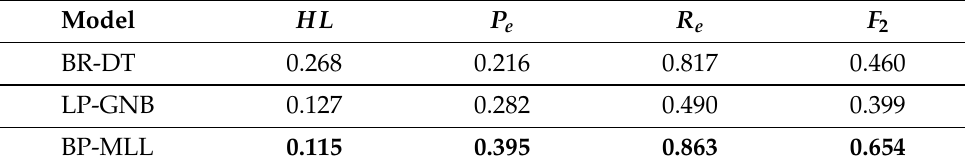
Table 2. Evaluation scores of the models in the task of ASJC code prediction for papers.